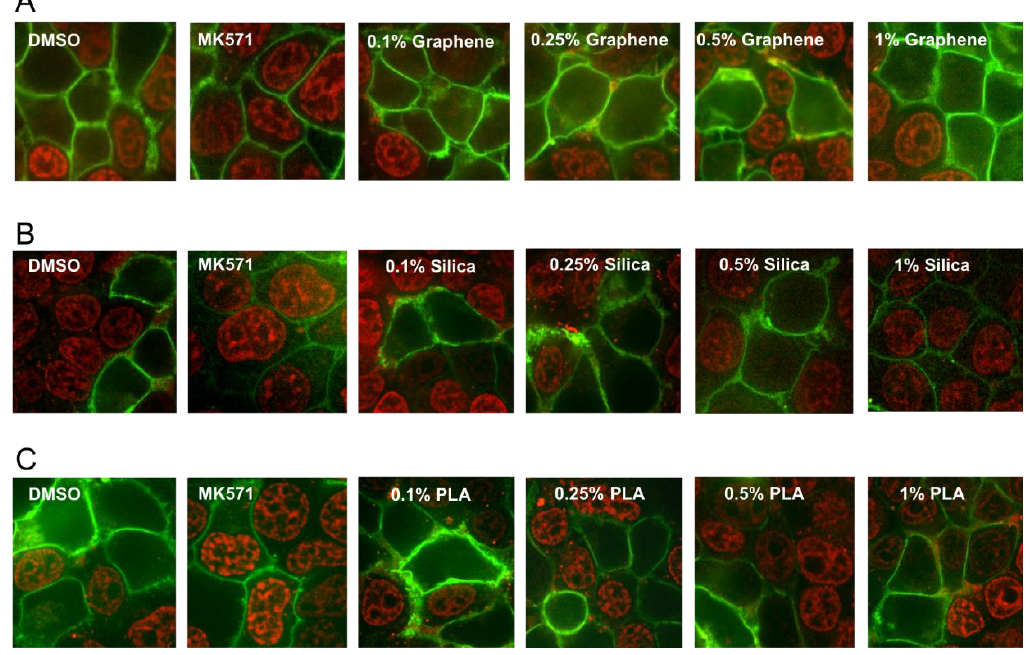
Figure 5. Effect of nanopolymer treatments on MRP1 efflux activity. Doxorubicin accumulation assay was used to measure MRP1 efflux activity. HEK293T cells transiently transfected with MRP1-GFP (green) were pre-treated with 0.1%, 0.25%, 0.5%, 1% Graphene (quantum dots) ( A ), (mesoporous) Silica ( B ), PLA nanoparticles ( C ) or 50 μM of MK571 (known MRP1 inhibitor), before incubation with doxorubicin (red) at 37 °C for 1 h. Images were acquired using confocal microscopy. GFP and doxorubicin were excited at 488 nm, and emission detected at 475/42 and 605/64 nm, respectively.